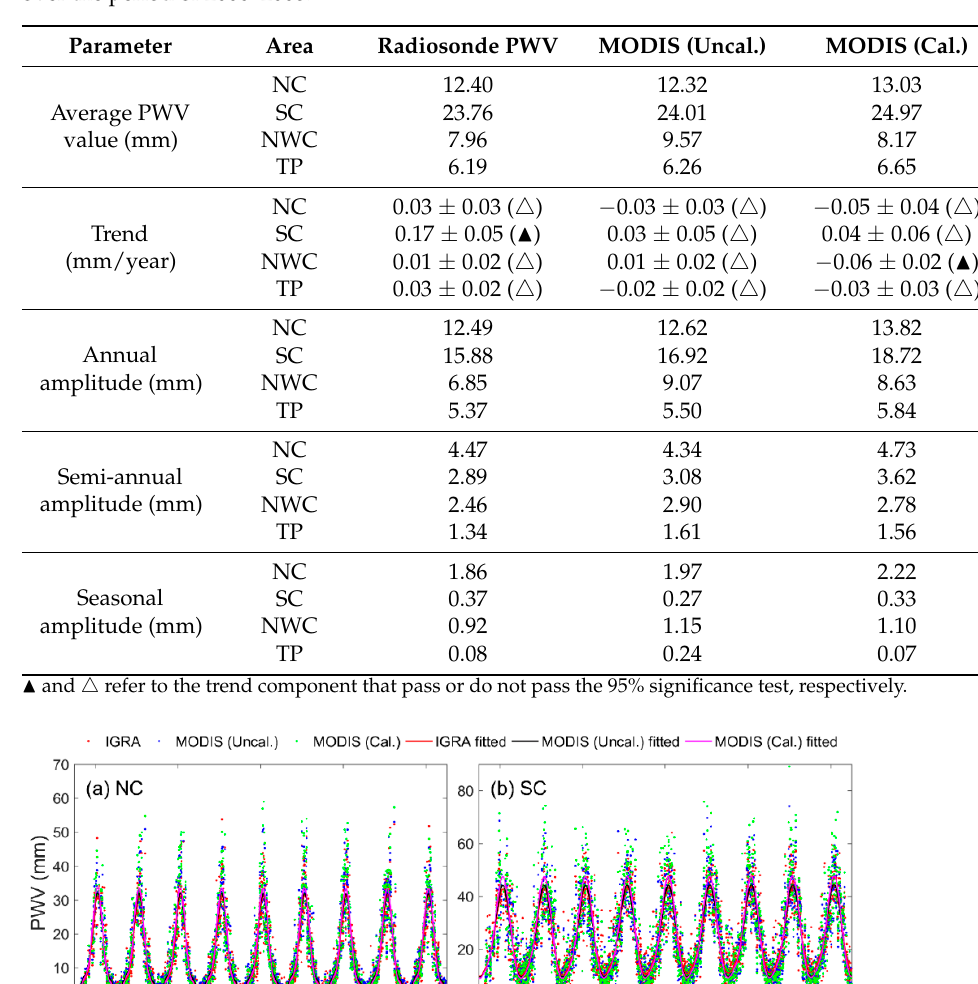
Table 9. Estimated parameters of linear PWV model using radiosonde and MODIS PWV time series over the period of 2000–2008.